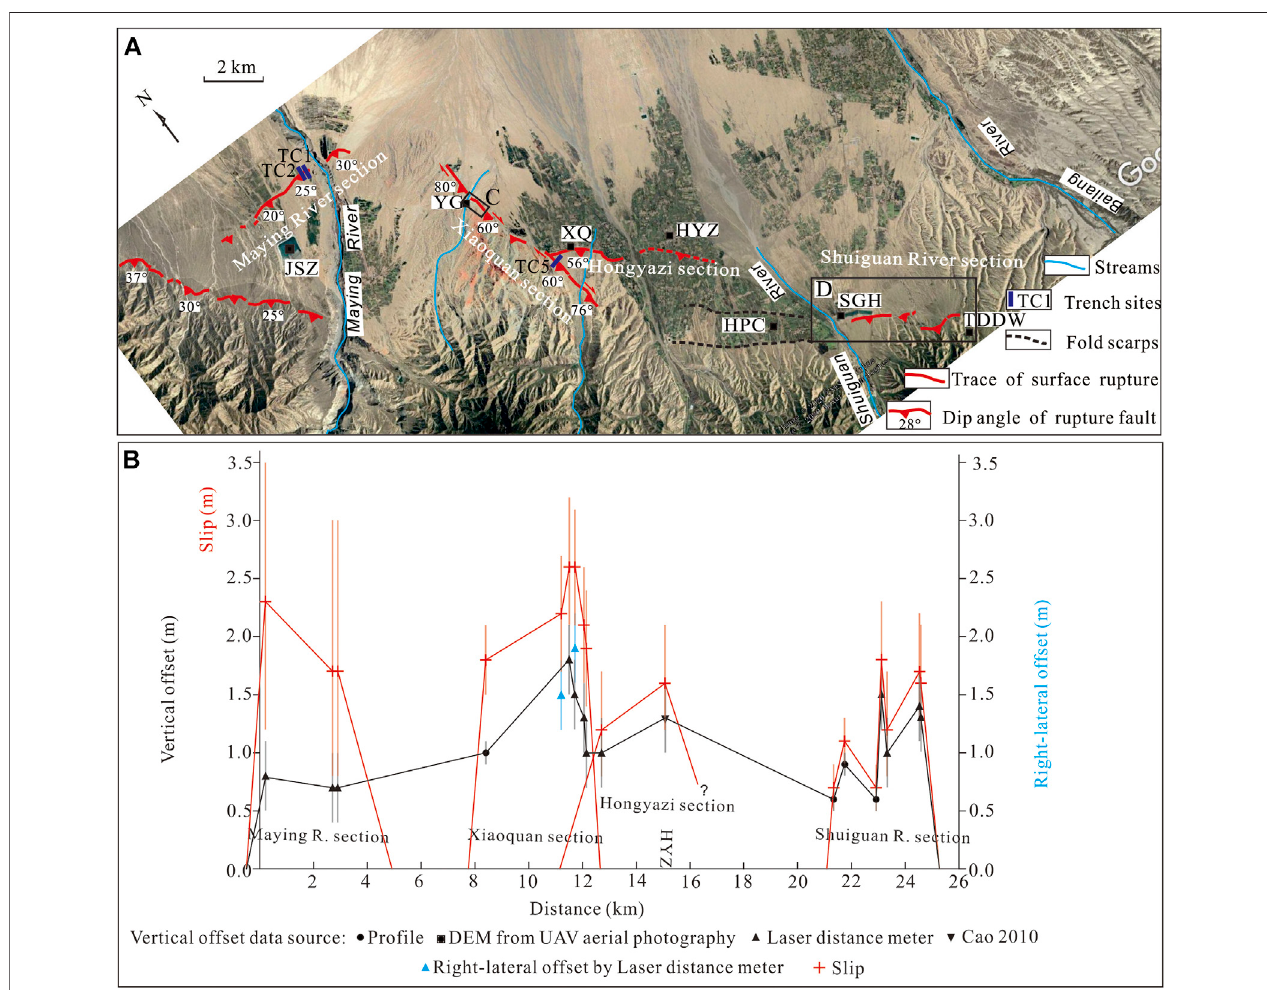
FIGURE 12 | (A) Map of the 1609 surface rupture in the eastern segment. Place names: JSZ, Jiashanzi; YG, Yagou; XQ, Xiaoquan; HYZ, Hongyazi; HPC, Heping Village; SGH, Shuiguan River reservoir; TDDW, Toudaodongwan. (B) Offset and slip of the 1609 earthquake in the eastern segment. Only one right-lateral offset data point, measured beside Tc5 in the area south of Xiaoquan, is plotted because the locations of the measurements were close and the data range was narrow around 1.5 m.The box signed C is the location of Figure 13A , and the box signed D is the location of Figure 13B .